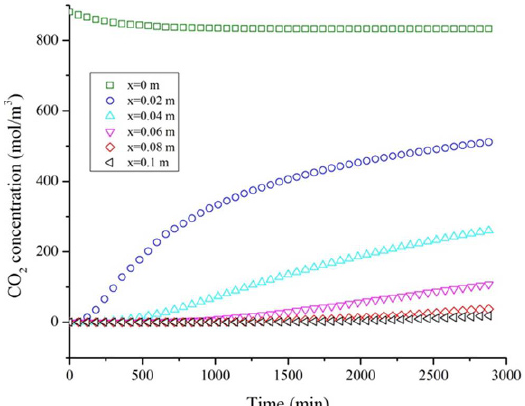
Figure 8. CO 2 concentration in the diffusion cell due to molecular diffusionmechanismat40 ◦ Cand5900kPainitialpressure versus liquid’s